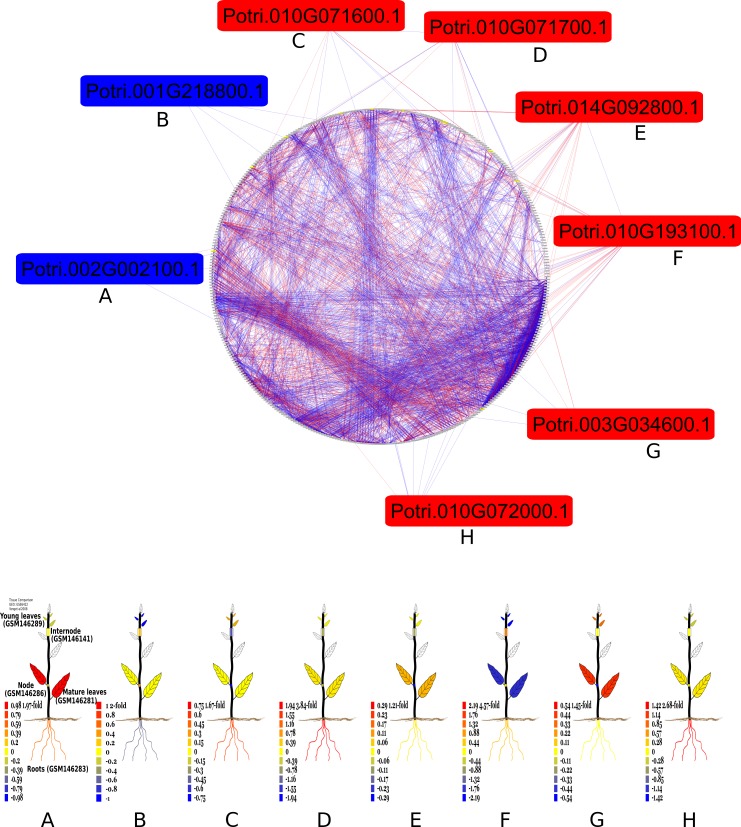
Co-expression network between genes with the same transcriptional regulation profile for aluminium toxicity and phosphate deficiency.Green rectangles refer to the activated genes and red rectangles to genes inhibited by both stresses; grey rectangles at the edge of the circle refer to genes with constant expression between the two stresses (variation below 20%). Blue lines refer to positive correlations and red lines to negative correlations, with p≥0.8.